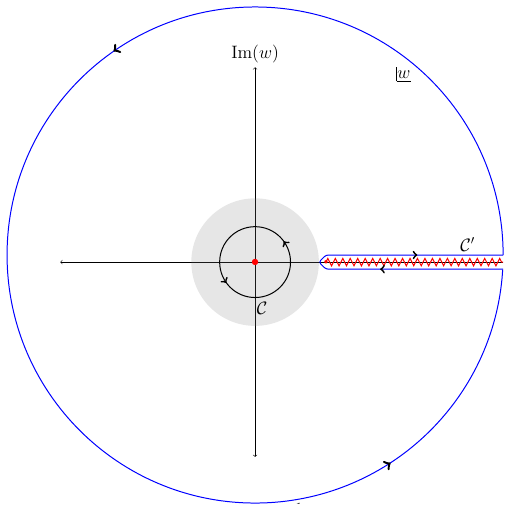
Figure 2 . The function f ( w, s, x ) is analytic in w in the shaded disc, but has a branch cut along the real axis starting at w = e 2 πE min (red line). The contour C that goes around the pole of f ( w, s, x ) /w 1+ n at the origin, can be deformed in to C 0 . This contour wraps the branch cut starting from e 2 πE min to ∞ . If f ( w, s, x ) /w is bounded at infinity, the arcs at infinity can be dropped to obtain